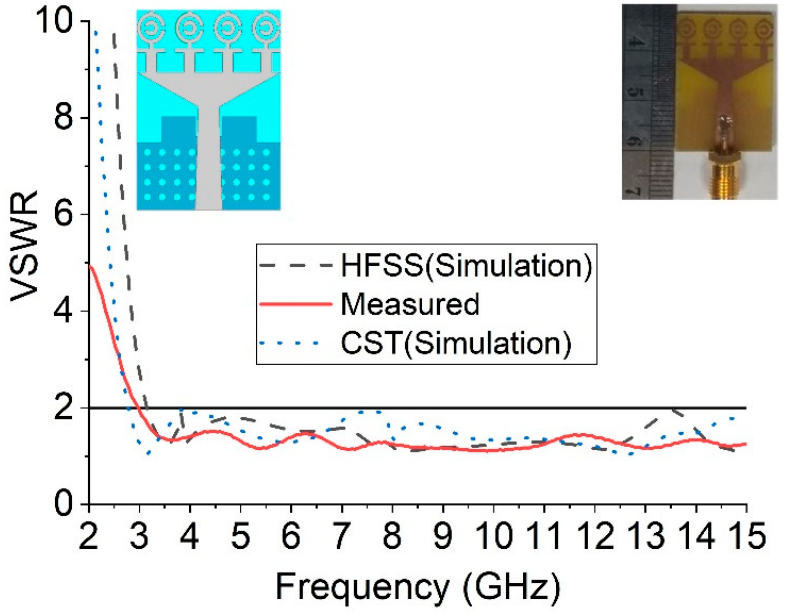
Figure 9. Measured and simulated VSWR curves.